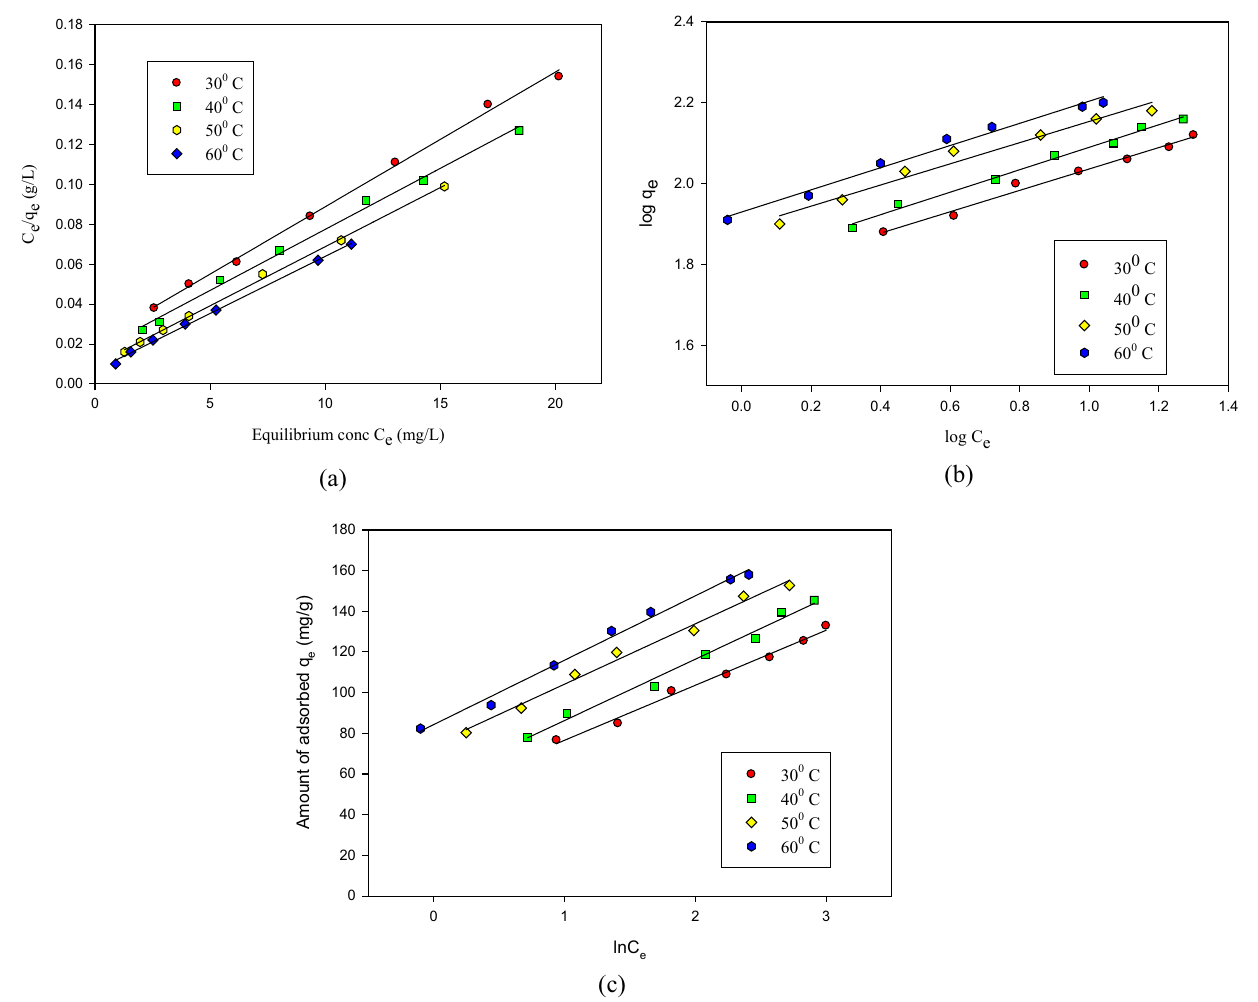
Fig. 7 a Plot of C q C e / e versus e to investigate the feasibility of Lang- muir isotherm for adsorption of methylene blue on coconut coir dust with varying temperature. b Plot of ln q e versus ln C e to investigate the feasibility of Freundlich isotherm for adsorption of methylene blue on